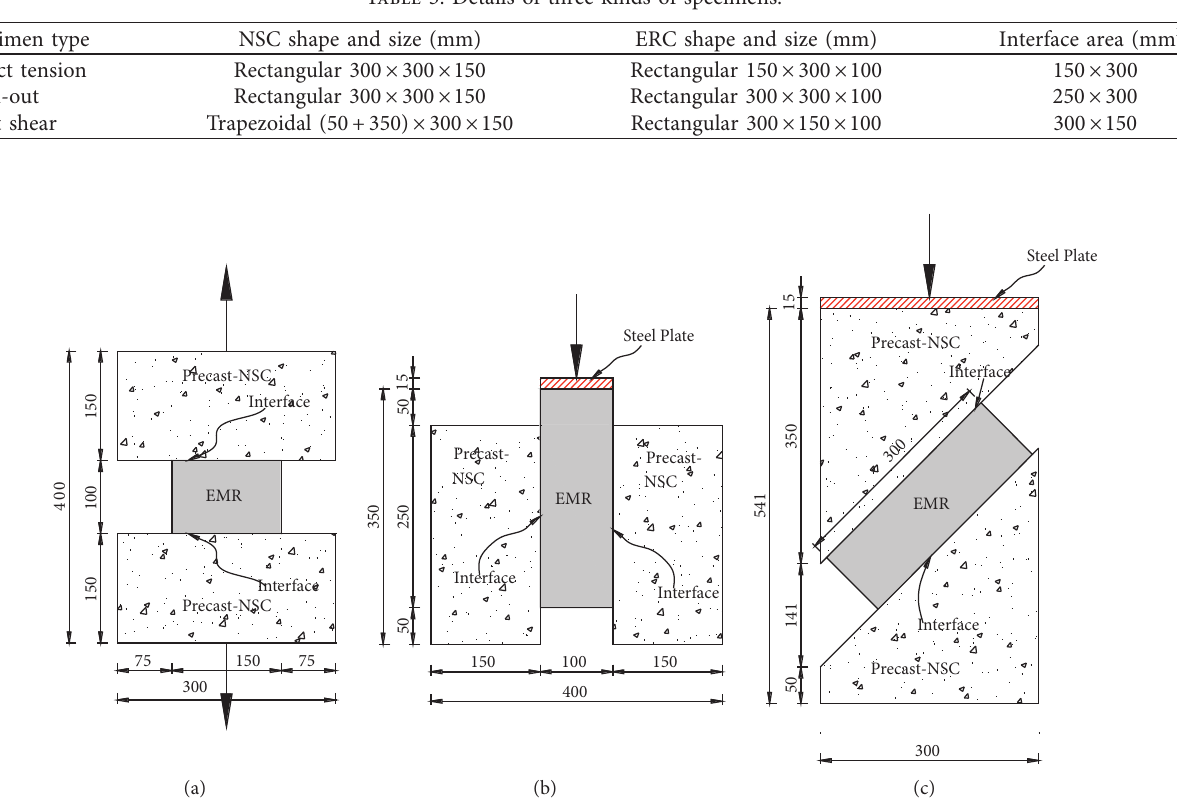
Figure 1: Specimen details for three tests: (a) direct tension; (b) push-out; (c) slant shear (all dimensions in